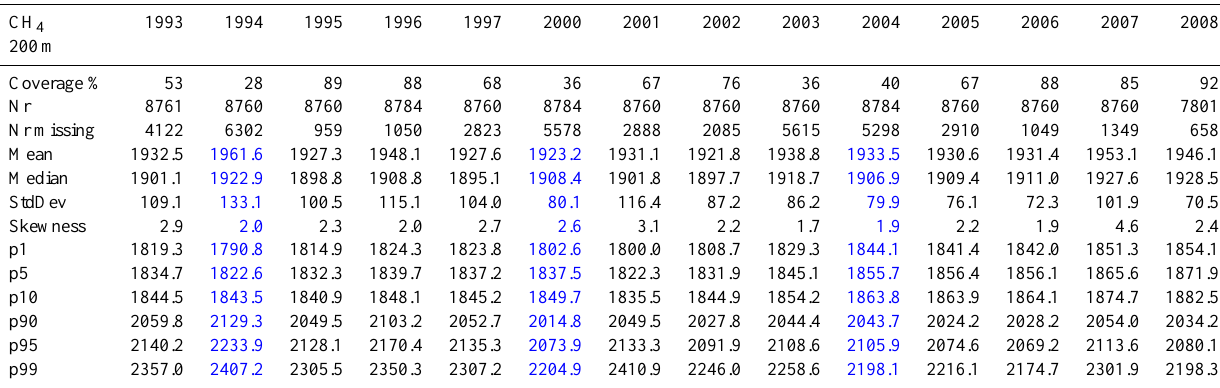
Table 5. Measurement results for CH 4 for the whole observation period. Numbers in blue refer to years with incomplete data because of instrumental failures or start or stop of the observations during that year. All concentrations in ppb. The coverage percentage is not corrected for calibration intervals